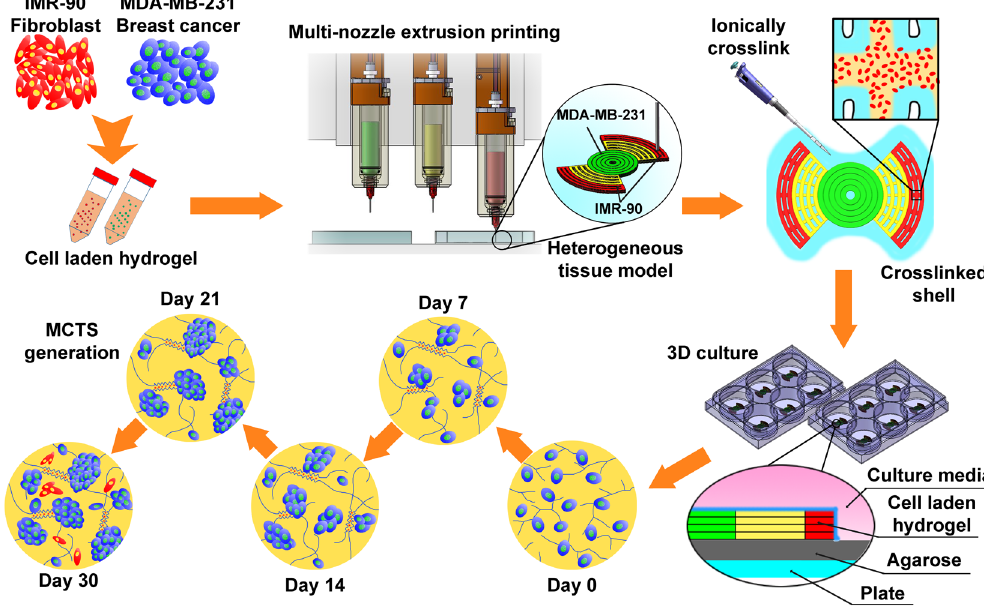
Figure 1. Schematic depicting the design, and experimental protocol, used to create a heterogeneous tumour model comprised of both MDA-MB-231 triple negative breast cancer cells and IMR-90